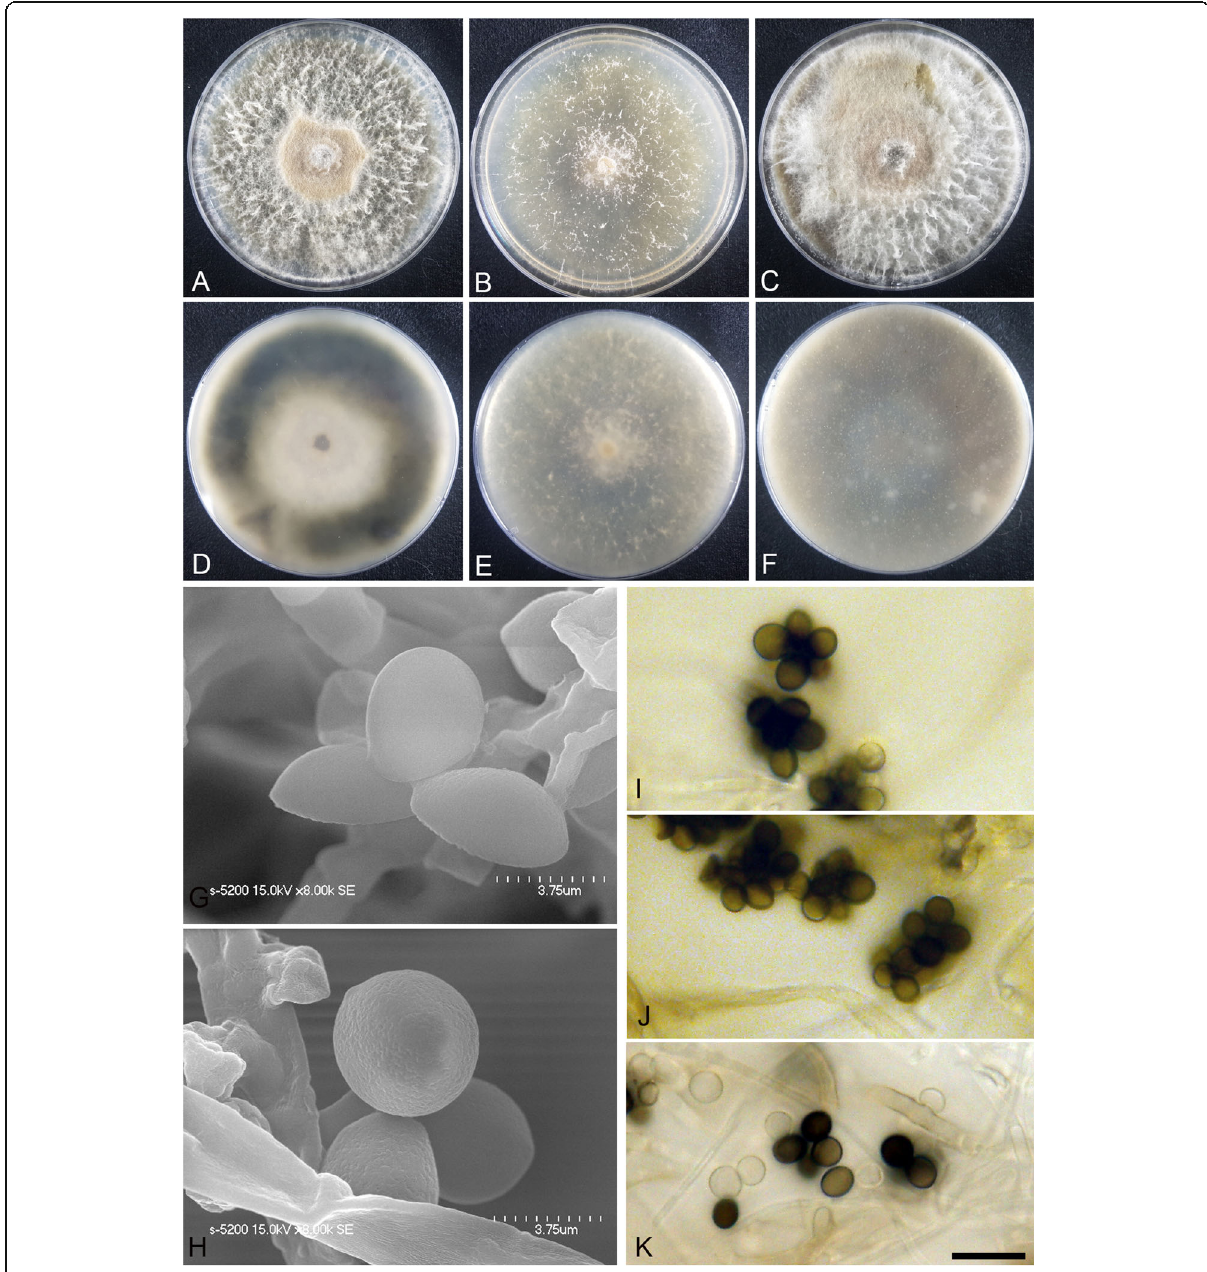
Fig. 8 Arthrinium pusillispermum (KUC21321). a-c , Colonies on PDA ( a ), MEA ( b ), and OA ( c ) (top); d-f , colonies on PDA ( d ), MEA ( e ), and OA ( f ) (bottom); g-h , conidia under SEM; i-k , conidia attached to conidiogenous cells; scale bar = 10 μ